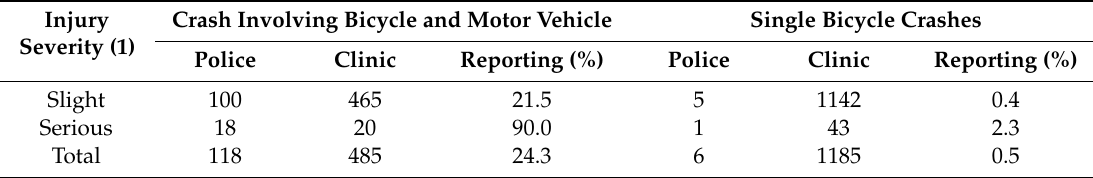
Table 1. Reporting of cyclist injuries in police statistics by injury severity and type of crash. Oslo 2014. Based on Elvik [11].